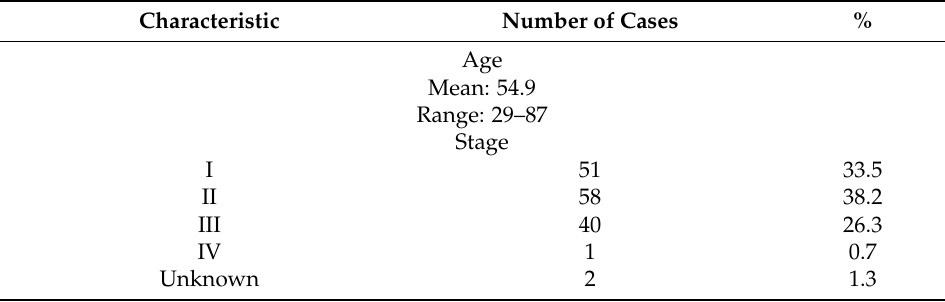
Table 2. Clinicopathologic features of the study